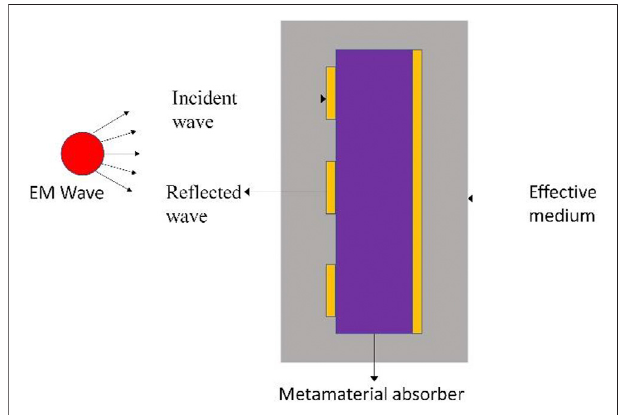
FIGURE 5 | Impedance matching in a metamaterial